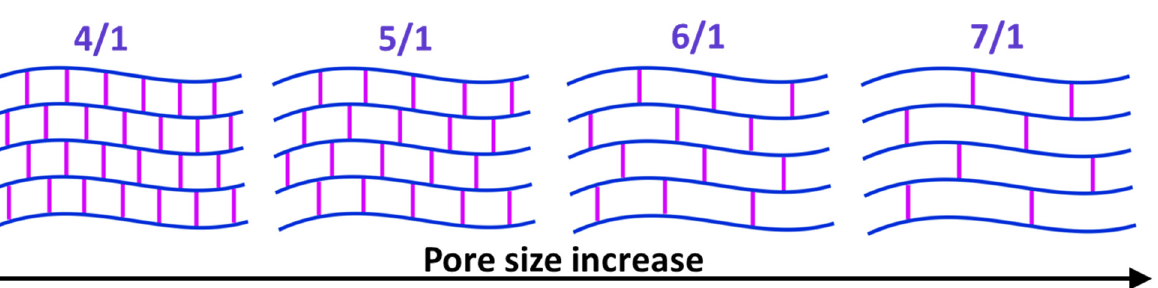
Figure 10. Schematic view of polyacrylamide gels with different crosslinking (acrylamide/bis- acrylamide) ratios according to the expected pore size variations.